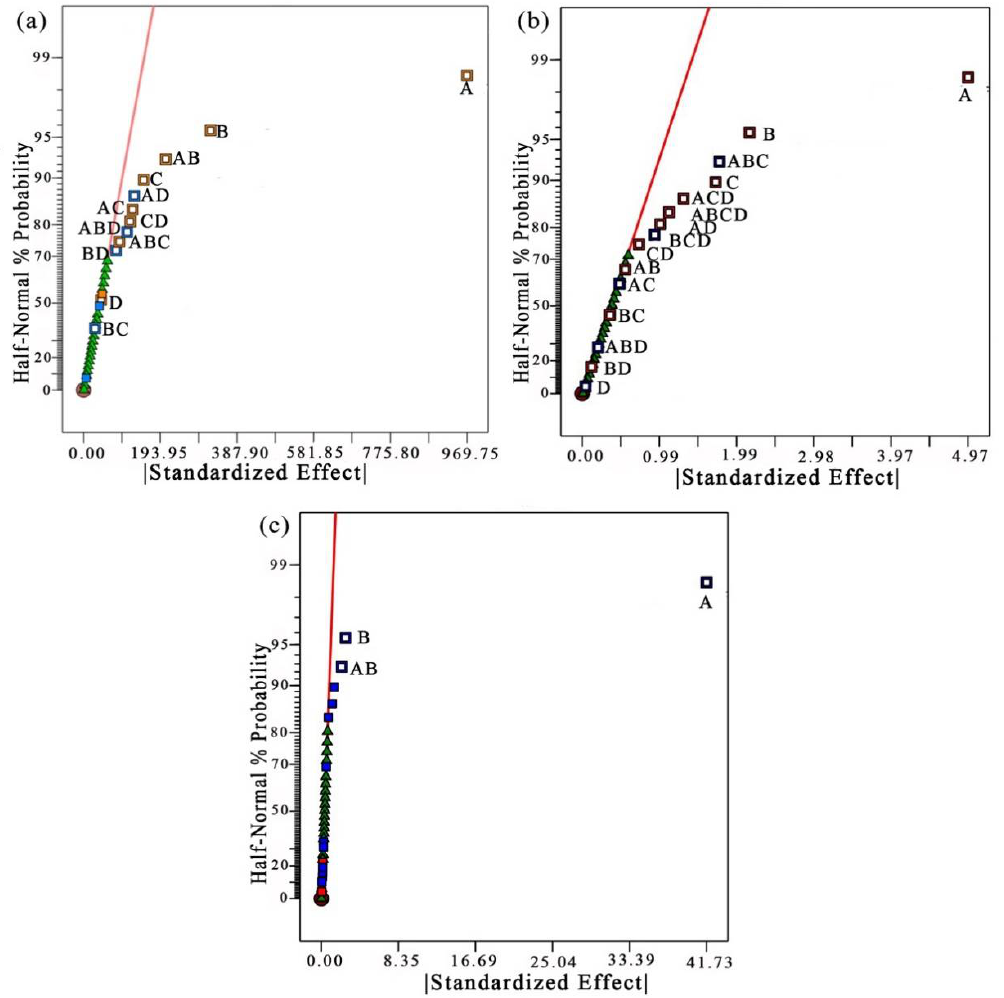
Figure 3. Half-normal plot graph for ( a ) elastic modulus, ( b ) hardness, and ( c ) weight loss. The p < 0.0500 shown in Table 3 indicates the significance of model terms A, B, C, AB, AC, AD, and CD for elastic modulus. Results from the analysis of variance (ANOVA) for hardness show that A, B, C, ABC, and ACD are also significant model terms ( p < 0.0500). For the percentage of weight loss, as shown in the same table, only A, B, and AB are the significant model terms ( p < 0.0500), while models C and D are insignificant ( p > 0.0500). According to statistical data, the model term D (sintering time) is found to be insignificant for all responses ( p > 0.0500). From the lack of fit (LOF) test, it was found that all responses are insignificant ( p > 0.0500), implying that the purpose model fits the experimental data, and the independent variables have a considerable effect on the responses. Table 3. ANOVA for elastic modulus, hardness, and weight loss.